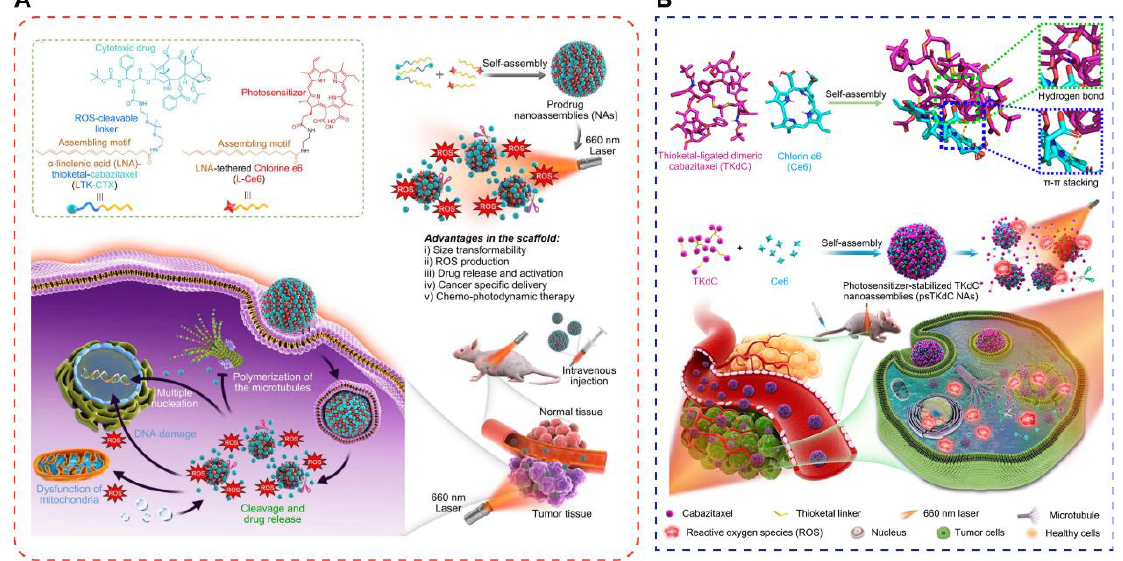
Figure 7. ( A ) Schematic illustrating photoactivatable self-assembling prodrug cocktail (PSPC) nano- medicines constructed from small molecules for tumor-specific drug activation and combined